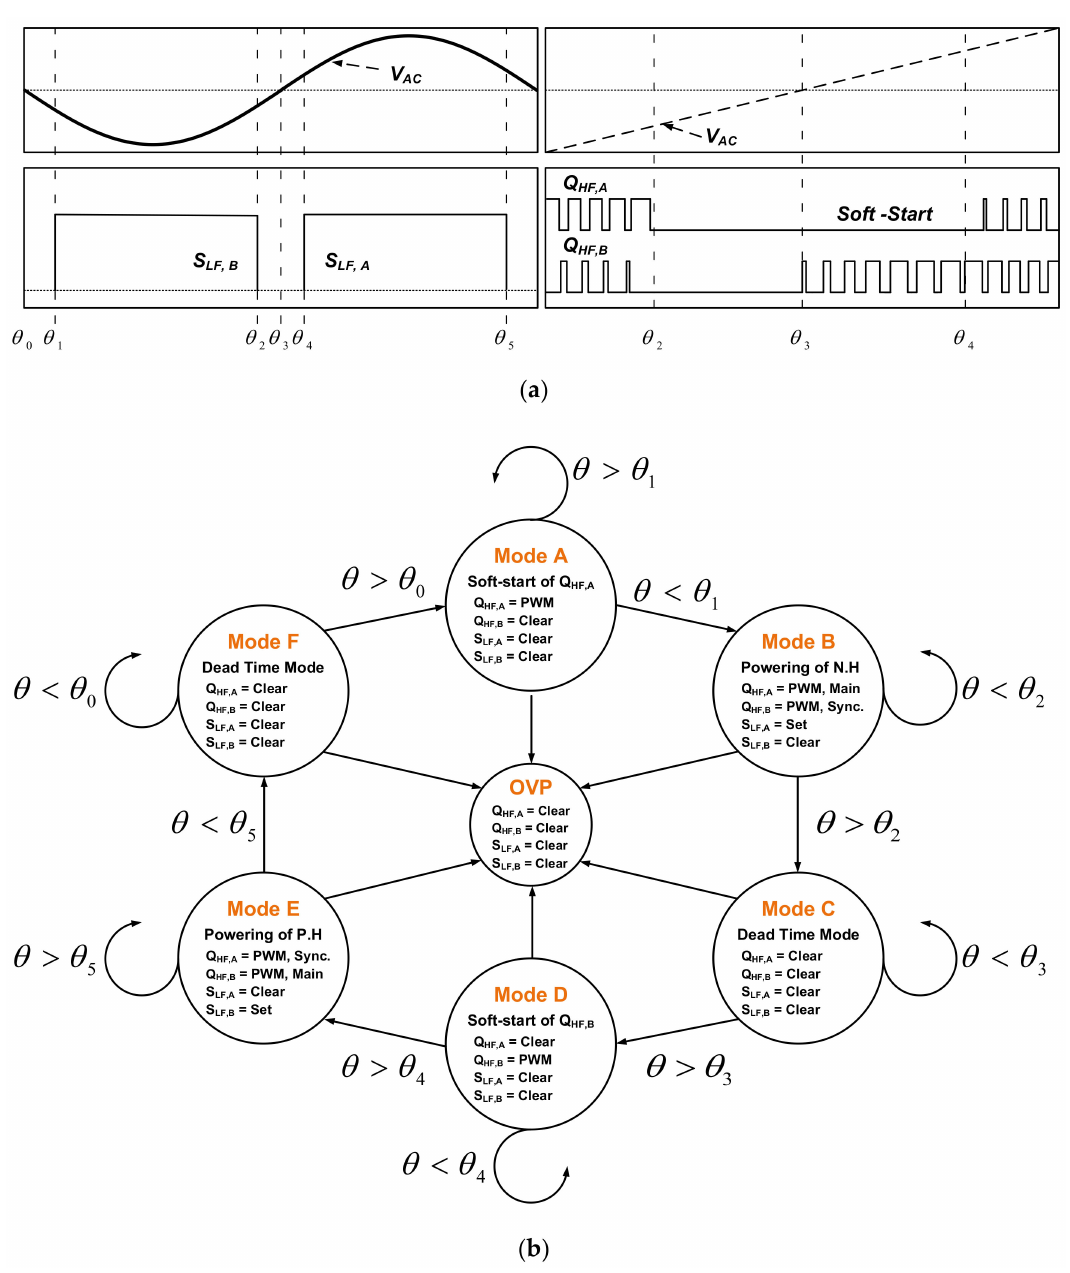
Figure 7. Control mode by the alternating current (AC) voltage period. ( a ) gate waveforms by AC voltage period and ( b ) state machine of totem-pole PFC by